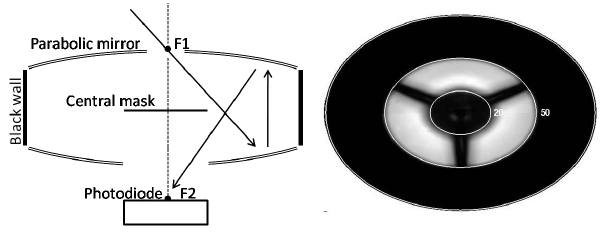
Figure 2. ODS optical head (on the left) made by two parabolic mirrors surrounded by black walls to avoid unwanted reflections, a central mask supported by 3 small legs and a photodiode. Rays entering the entrance hole at the focal point F1 (black arrows), are reflected by the parabolic mirrors and focused on the photodiode focal point F2. Right: measured ODS field of view. White and black areas correspond to 100 and 0% of transmission, respectively. Most light is collected between 25 and 50 ◦ .